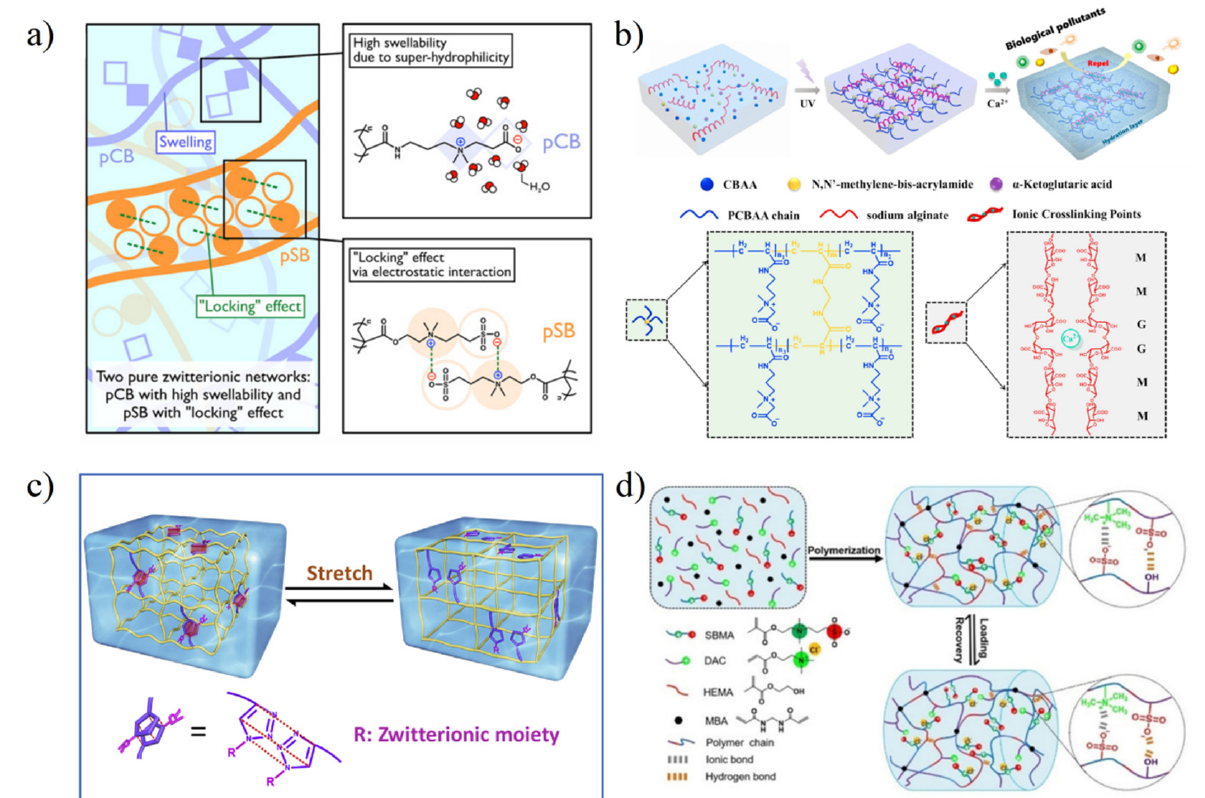
monomers (Figure 5d) [44,58–66]. At present, through the selection of different monomers, zwitterionic hydrogels have been able to achieve various aspects of strength and elasticity regulation to promote their application.